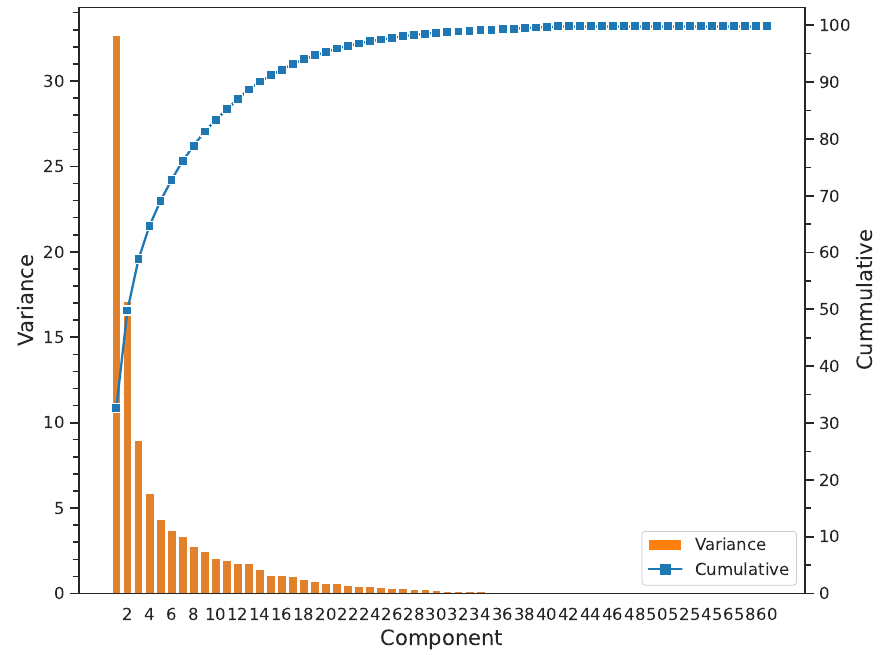
Figure 13. The Pareto histogram for the 60 components of the Principal Component